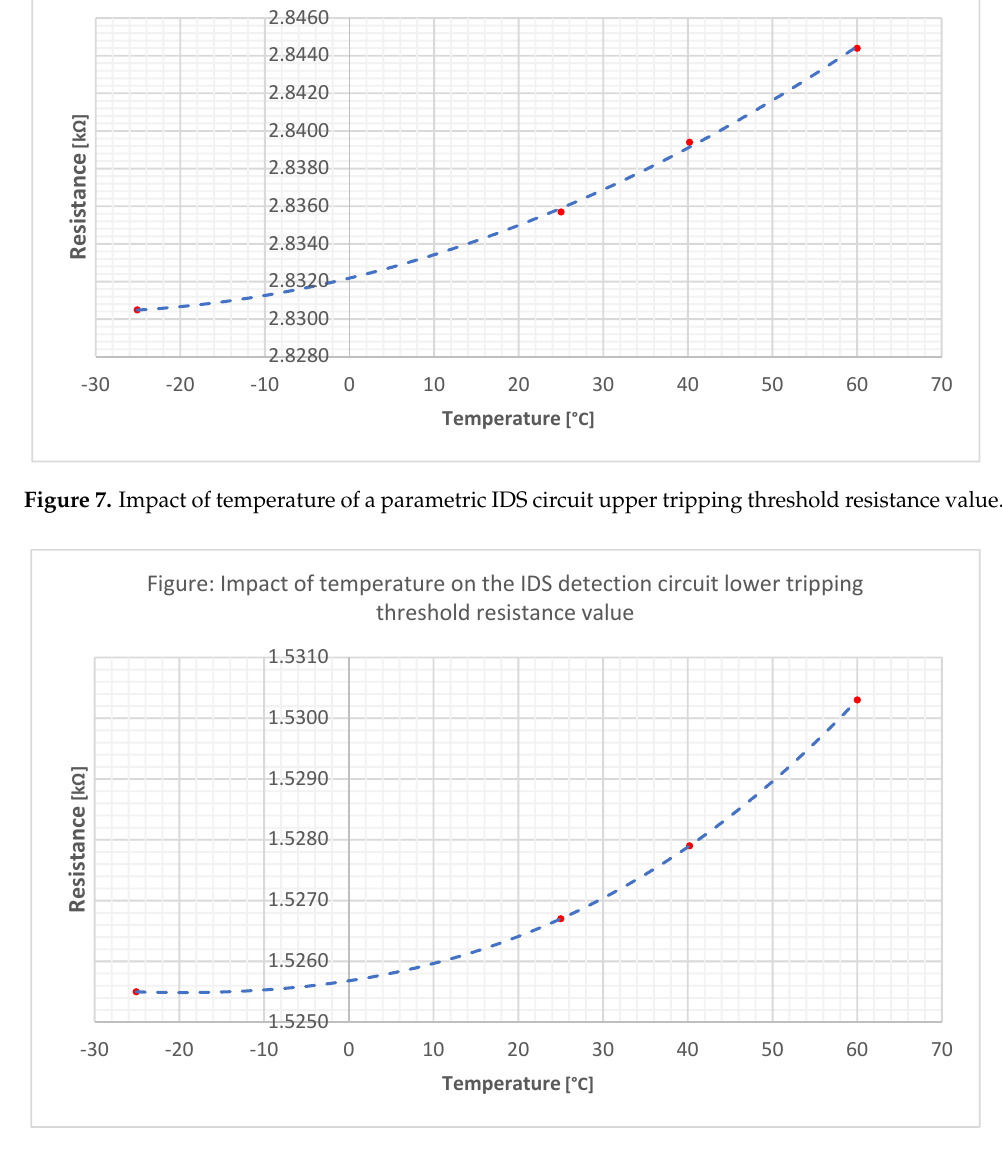
Figure: Impact of temperature on the IDS detection circuit upper